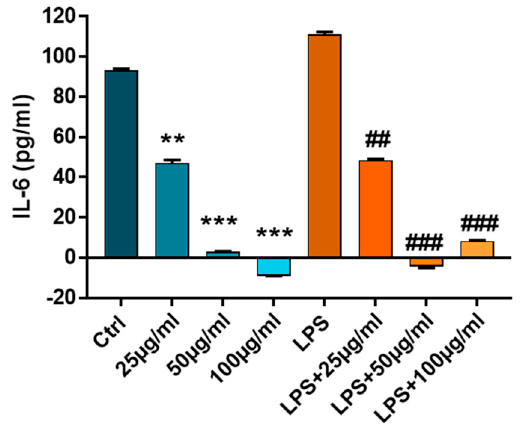
Figure 8. The protein expression of IL-6 released in the conditioned medium from control cells or cells activated with LPS (100 ng/mL) and treated with PFs (25, 50 and 100 μ g/mL). n = 3, ** p < 0.01, *** p < 0.001, PFs versus control cells and ## p < 0.01, ### p < 0.001 PFs versus LPS.